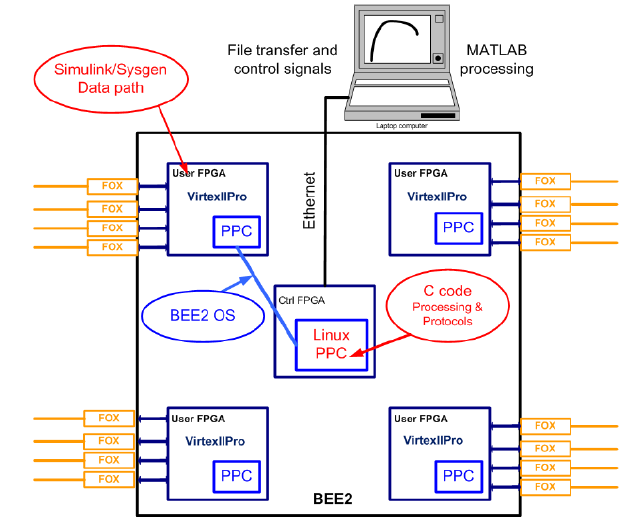
Figure 11. Software design flow for mapping of algorithms and protocols on